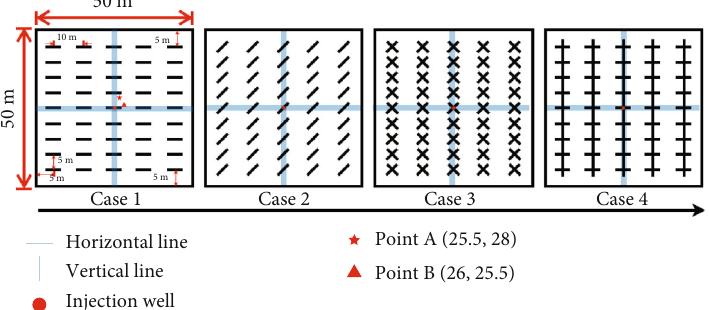
Figure 7: Model domain, fracture con fi guration, monitoring lines, and points for four cases. In cases 1 and 2, 45 fractures uniformly distributed through the entire coal reservoir are aligned at orientations of θ = 0 ° and 45 ° , respectively, and cases 3 and 4 contain two sets of orthogonal fractures with angles θ = 45 ° and − 45 ° and θ = 0 ° and90 ° ,